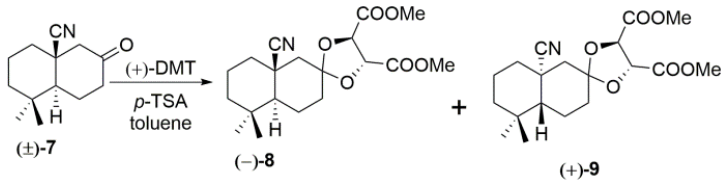
Scheme 3. Synthesis of ketal diastereomers ( − )- 8 and ( + )- 9 .